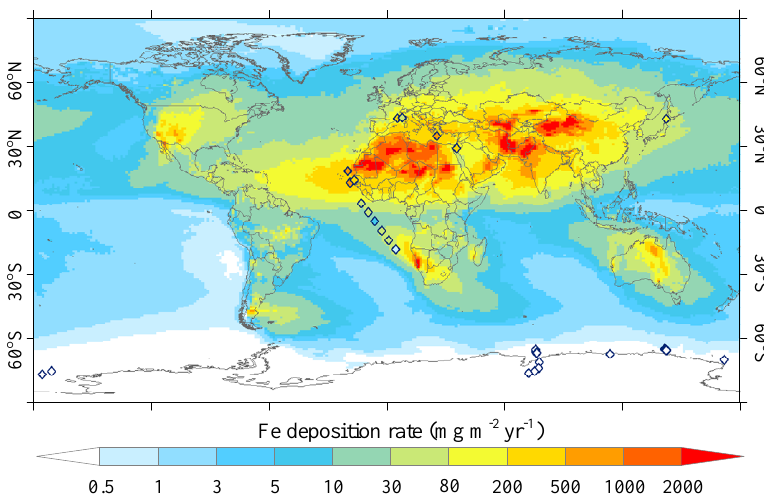
Figure 16. Global distribution of modelled annual mean Fe deposition rates. The observed Fe deposition rates from in situ measurements compiled by Mahowald et al. (2009) are shown as diamonds of the same colour as the